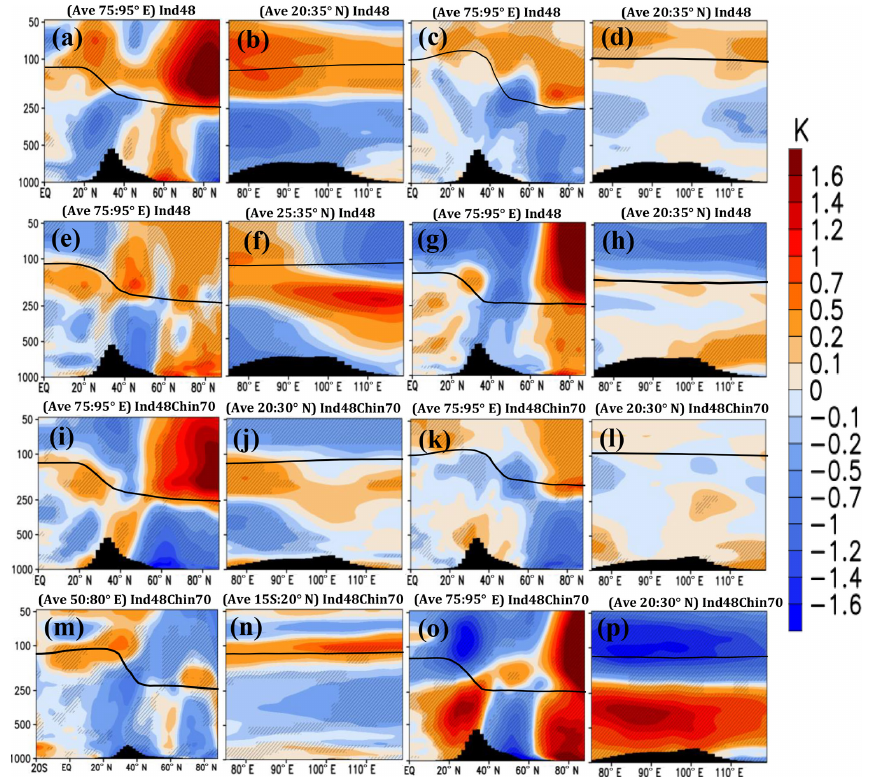
Figure 8. Vertical cross section of anomalies in temperature (K) from Ind48-CRTL simulations for the pre-monsoon season (a) latitude– pressure section and (b) longitude–pressure section; (c) – (d) same as (a) – (b) but for the summer-monsoon season; (e) – (f) same as (a) – (b) but for the post-monsoon season; (g) – (h) same as (a) – (b) but for the winter season. Figures (i) – (p) same as (a) – (h) but from Ind48Chin70-CRTL simulations. For the vertical cross section, averages obtained over latitudes or longitudes are indicated in each panel. The black hatched lines indicate the 99% significance level. The black vertical bars indicate topography, and a black line indicates the